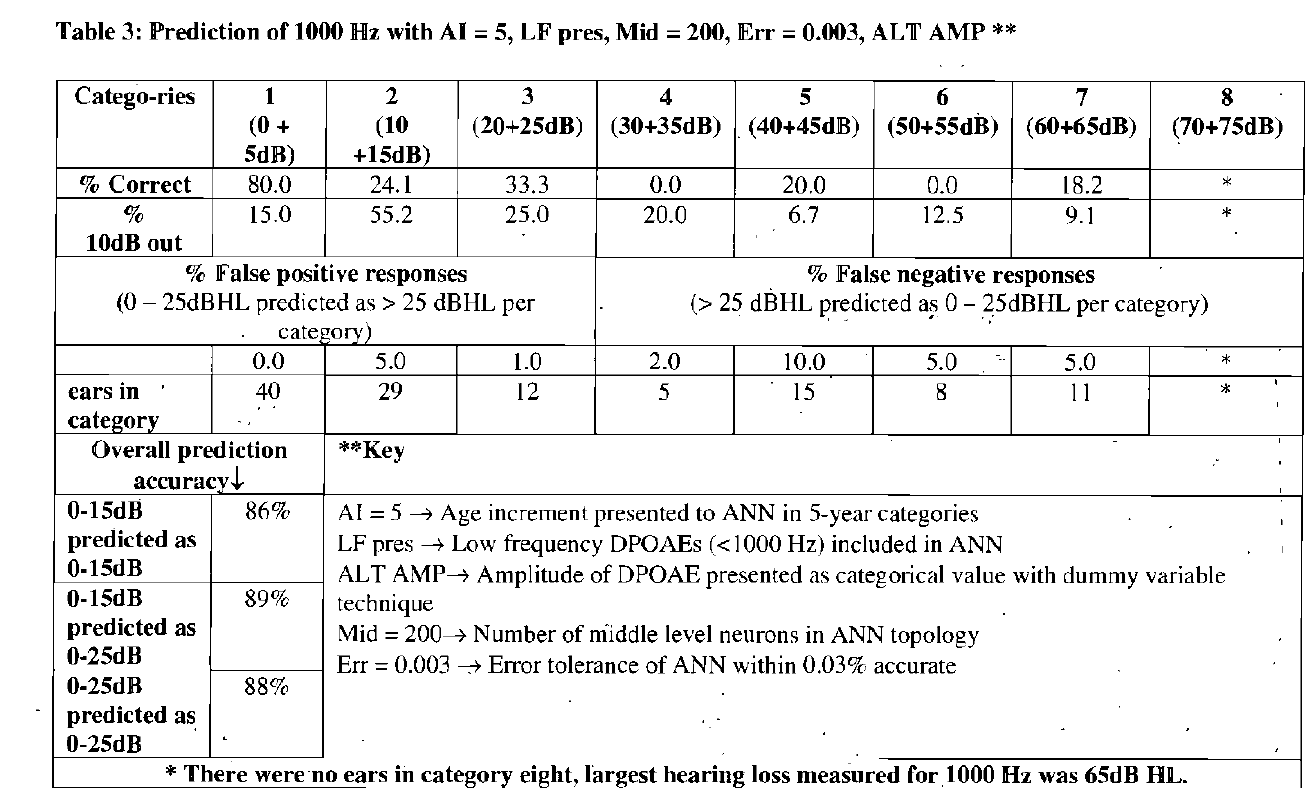
Al = 5 —» Age increment presented to ANN in 5-year categories LF pres —» Low frequency DPOAEs (<1000 Hz) included in ANN ι ALT AMP—» Amplitude of DPOAE presented as categorical value with dummy variable technique Mid = 200—»Number of middle level neurons in ANN topology Err = 0.003 -t Error tolerance of ANN within 0.03%